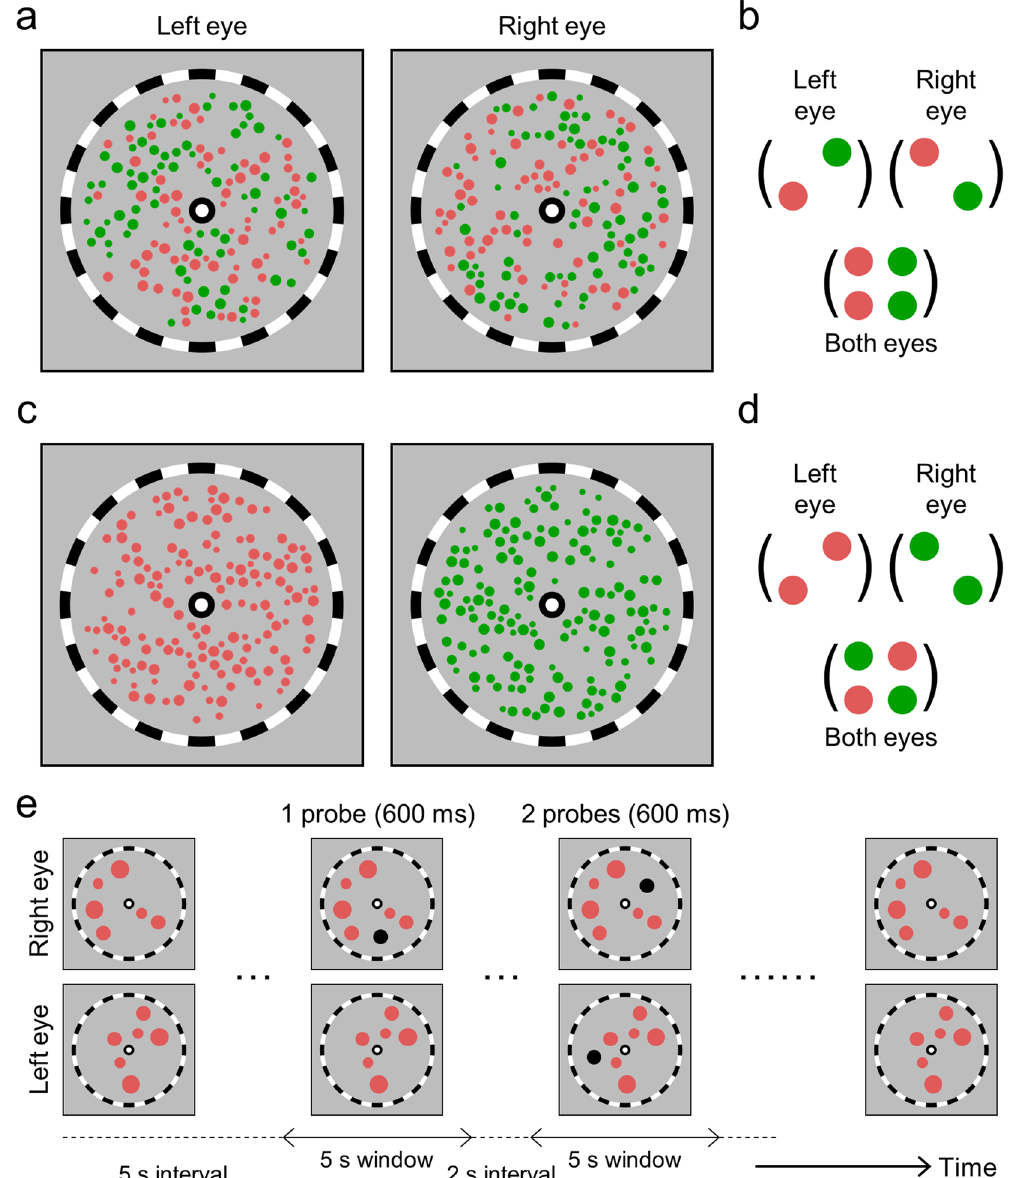
Figure 5. Example stimuli of the combined colour condition in Experiment 2 are shown in ( a ) and the dissimilar colour condition in ( c ). Stimuli in those two conditions are dissimilar in terms of dichoptic monocular ensembles yet similar in joint, binocular ensembles ( b , d ). The same colour condition is not depicted in this figure, but was tested in Experiment 2. The procedure of a single trial in Experiment 2 is shown in ( e ). Note that when two probes appeared simultaneously, they always appeared at different retinal locations in different